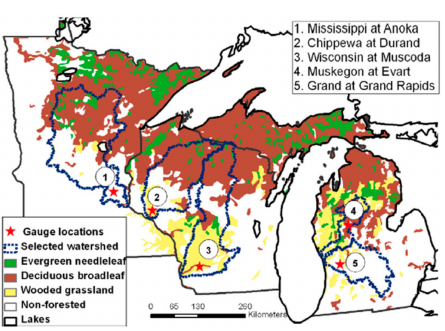
Figure 2. Modern land cover map of three states within the Great Lakes region together with watersheds and gauge stations for model hydrological calibration [21].